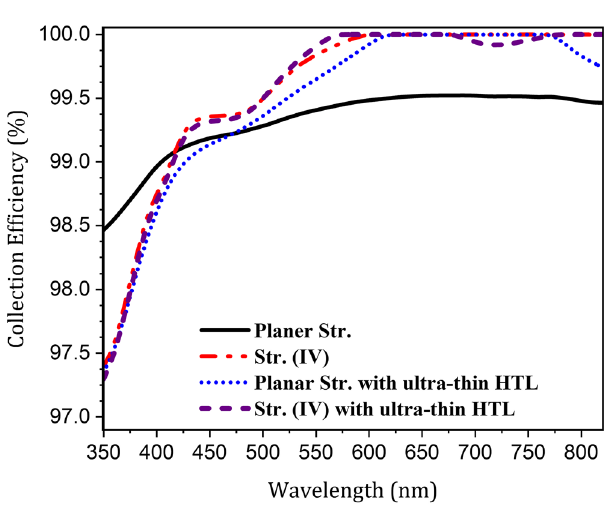
Fig. 9. Profile of normalized electric field in ultra-thin HTL structure in the absence and presence of nanostructures. ( a , d ) At the wavelength of 690 nm, ( b , e ) at 760 nm, and ( c , f ) at 800 nm.